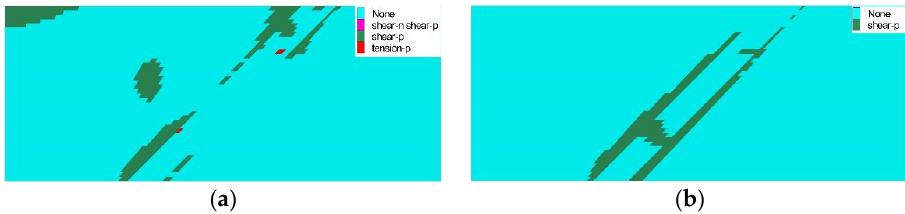
Figure 16. Cloud map of plastic zone distribution of different backfilling bodies. ( a ) Full tailings cemented backfilling and ( b ) Medium and fine tailings paste backfilling.